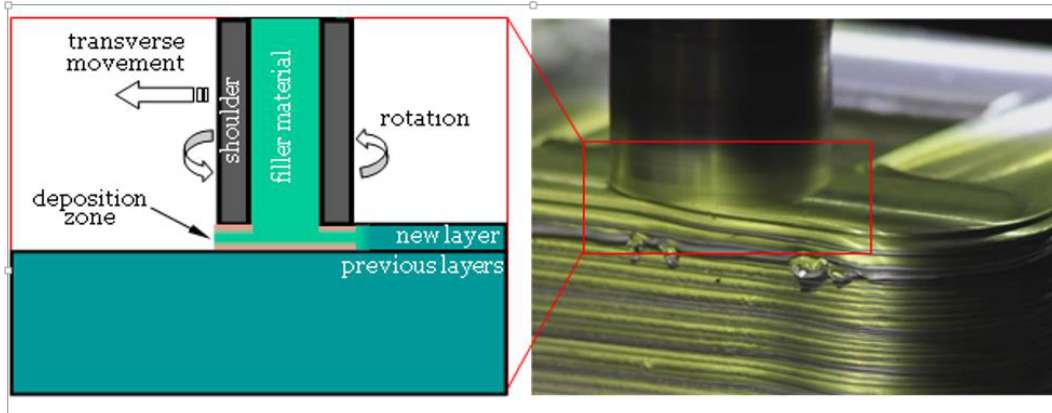
Figure 7. Schematic view of AFSD process ( left ), AFSD head in operation ( right image , courtesy of Aeroprobe Corporation, USA).